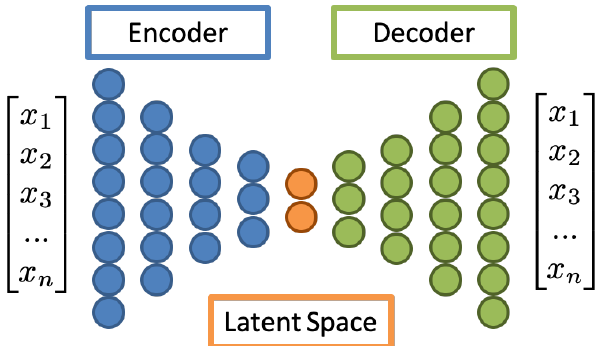
Figure 1. Schematic diagram of an autoencoder. A properly trained autoencoder will correctly reconstruct the input data while reducing the overall